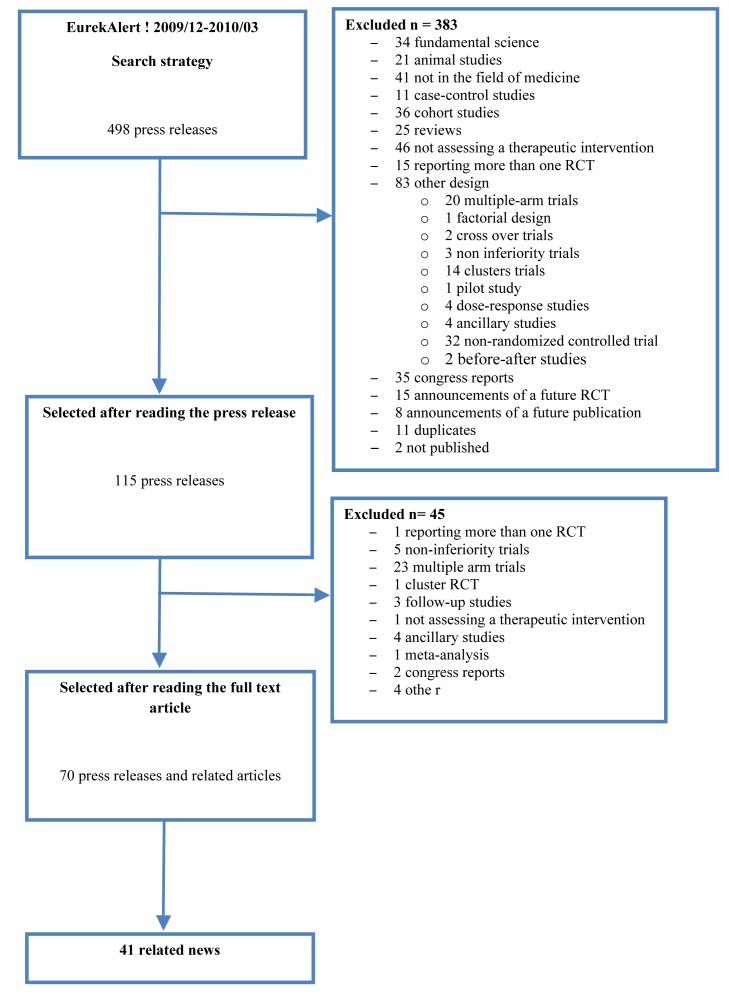
Flow diagram of the selected press releases and related articles.